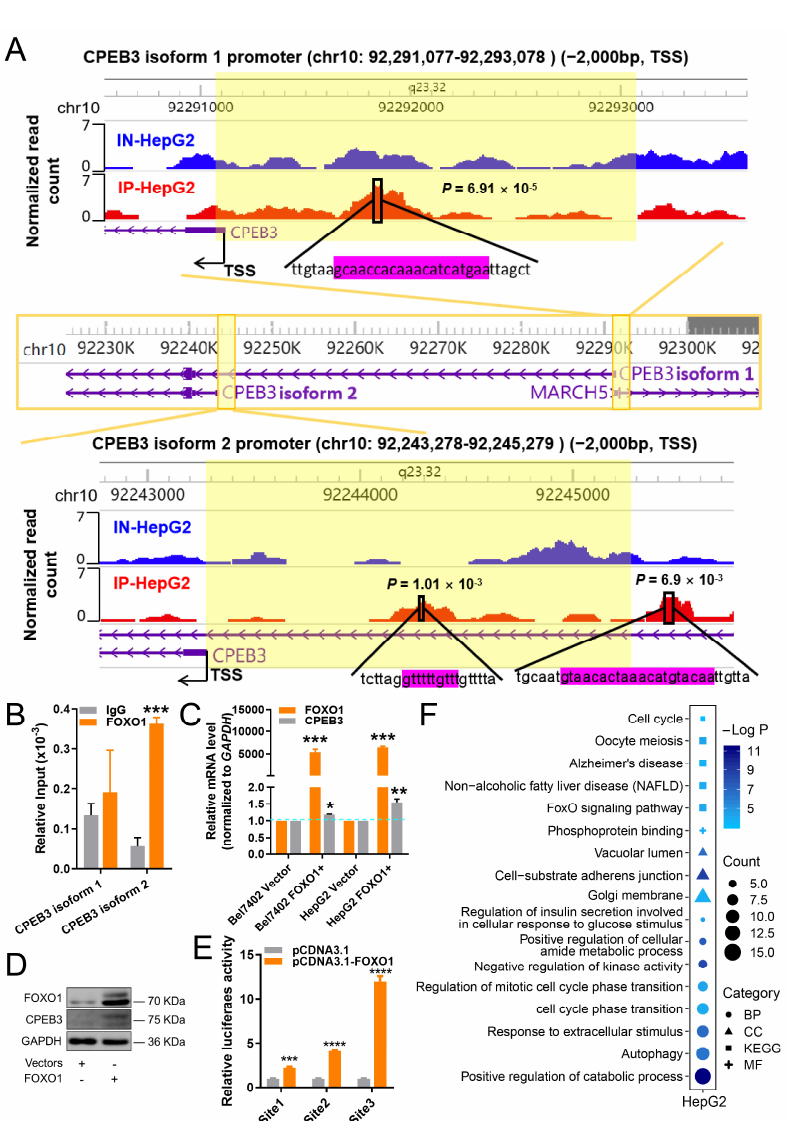
Figure 4. FOXO1 is a positive regulator of CPEB3 . ( A ) ChIP-Seq tag profiles for FOXO1 normalized read count at the CPEB3 promoters of two isoforms (NCBI: NM_014912.5 for isoform 1, NM_001178137.1 for isoform 2) in HepG2 cells under no-immunoprecipitation (IN) or immunopre- cipitation (IP) conditions. Locations of FOXO1-binding sites (magenta color) are indicated. p -value of each binding site was calculated by MACS2. Light yellow indicates the promoter region of CPEB3 . TSS, transcription start site. ( B ) Estimation of ChIP-Seq via quantitative ChIP-PCR in HepG2 cells normalized by input control, IgG served as a negative control. CPEB3 isoforms 1 and 2 were the same as shown in ( A ). Mean ± s.e.m., n = 3/group. ( C ) Gene expression levels of FOXO1 and CPEB3 were quantified by qRT-PCR as relative expression to control (vector). Expression of control was normalized to 1. Student’s t -test. Mean ± s.e.m., n = 3/group. ( D ) Protein expression of FOXO1 and CPEB3 was assessed by Western blot assay in HepG2 cells. ( E ) HepG2 cells were transfected with three sites of CPEB3 promoter with firefly and Renilla luciferase reporter constructs and plasmids, respectively, as indicated. At 48 h after transfection, renilla luciferase activity was normalized to firefly activity and is presented as relative luciferase activity, as described in “Supplementary Meth- ods”. Site 1 indicates the binding site of FOXO1 to CPEB3 isoform 1 in ( A ), while site 2 and site 3 indicate the binding sites of isoform 2 of CPEB3 (( A ), bottom, left and right sites, respectively). Stu- dent’s t -test. Mean ± s.e.m., n = 3/group. ( F ) Significantly enriched terms ( p < 0.01) in Gene Ontology and KEGG pathway for DEGs of FOXO1 overexpression compared with control in HepG2 cells. CC: cellular component. BP: biological process. MF: molecular function. * p < 0.05, ** p < 0.01, *** p < 0.001, **** p < 0.0001, ns: non-significant.